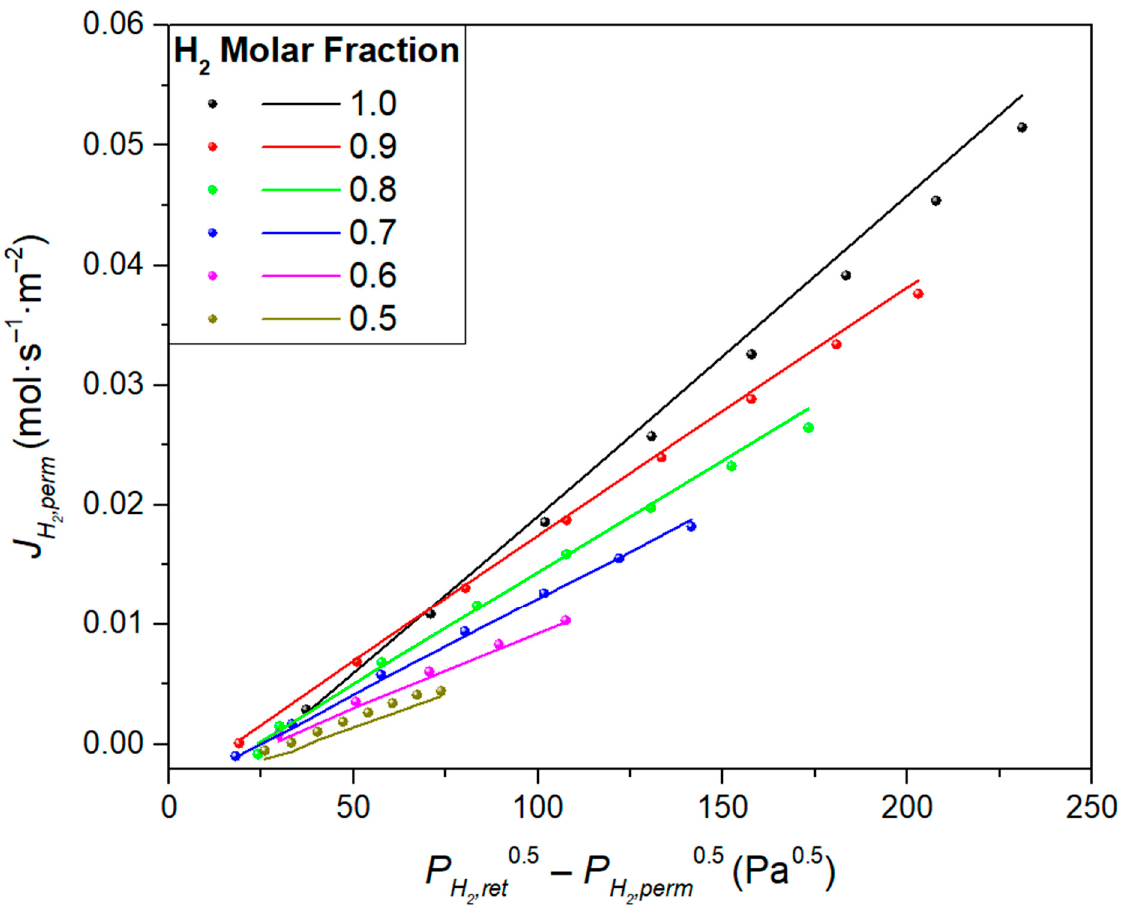
Figure 6. Experimental (symbols) and predicted (lines) H 2 permeate fluxes at a constant temperature ( T = 375 °C) but different pressures and H 2 molar fractions in the feed stream (in–out configuration).